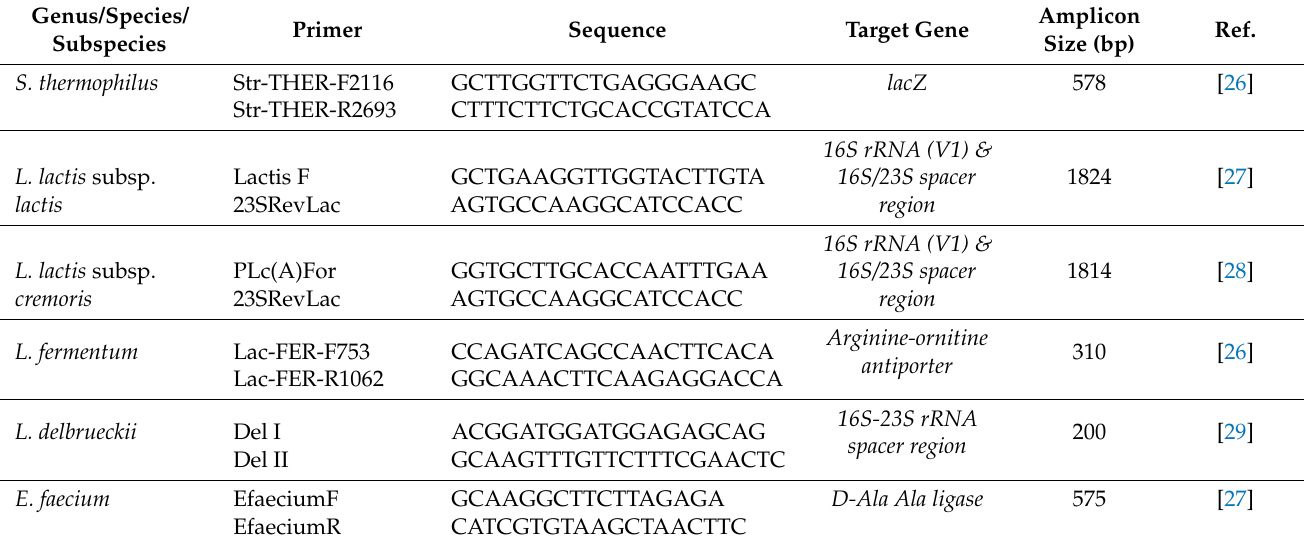
Table 1. Primers used for species- and subspecies-specific PCR